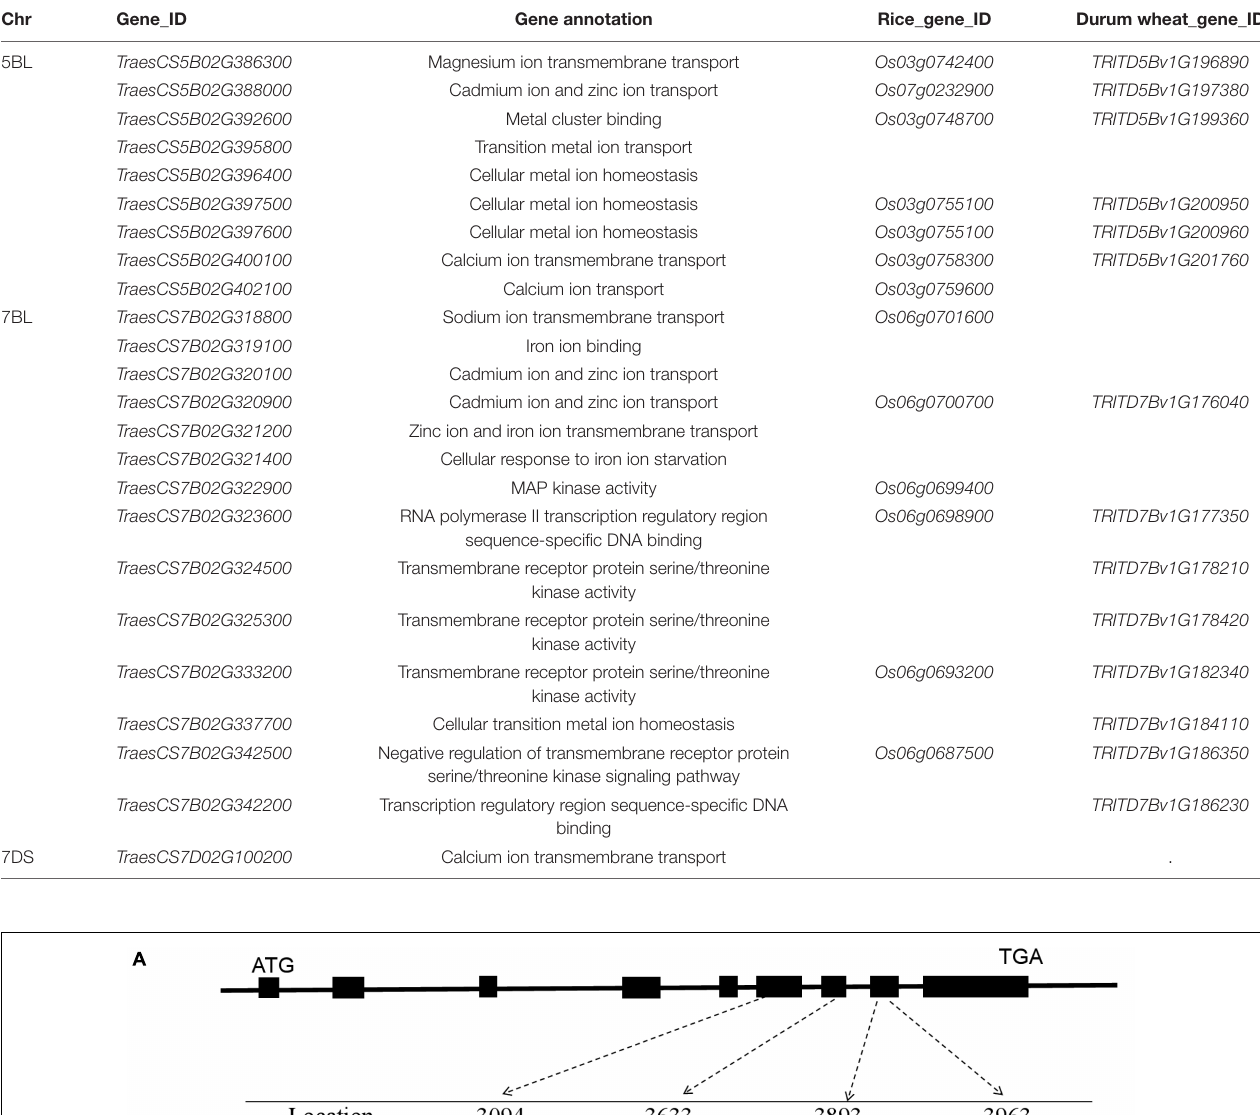
TABLE 6 | Candidate genes significantly associated with Cd and either metal uptake or transport in the three major QTL regions identified in this study. Chr